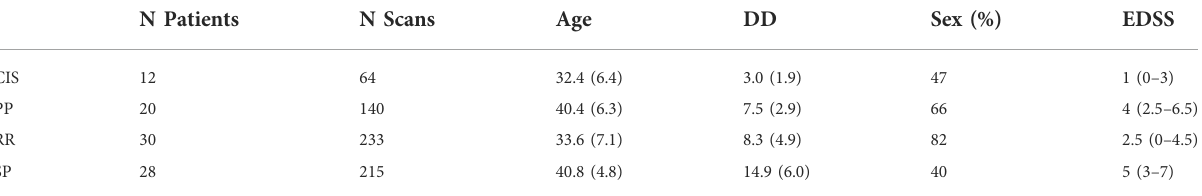
TABLE 2 Summary information of the dataset partition into MS clinical pro fi les (CIS, RR, SP, PP) and healthy subjects. Average values for Age (at fi rst scan) and Disease Duration (DD) with standard deviation in parentheses is reported. Median values of EDSS is provided along with range of variation in parentheses. Percentage of female patients is